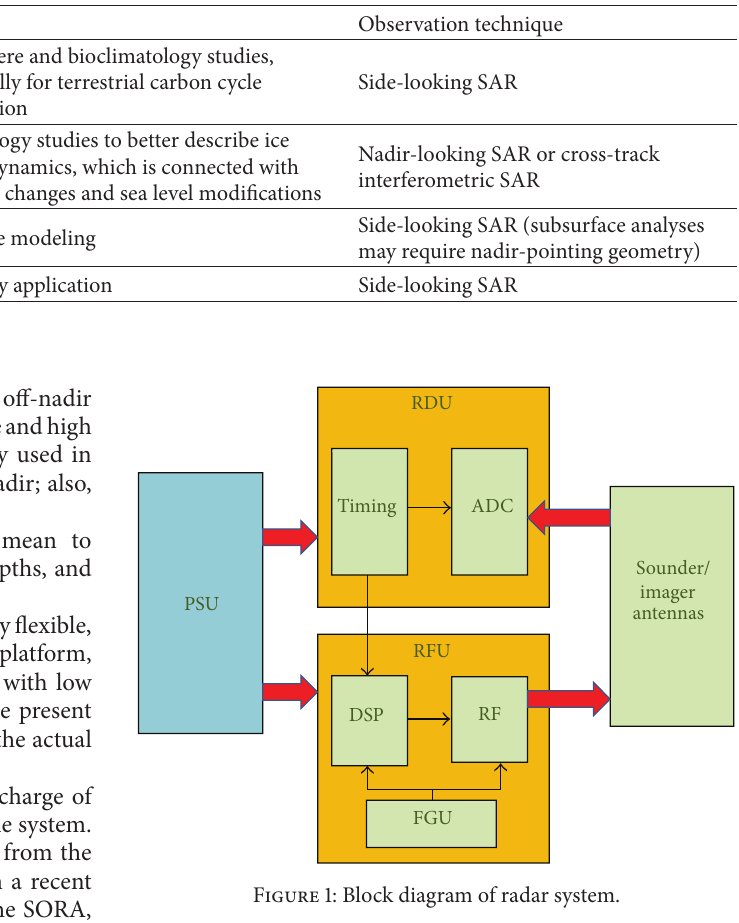
Table 1: Applications for low frequency airborne radars.